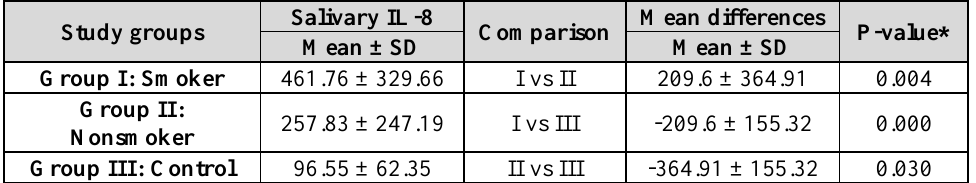
Table 2: Comparison of the three groups with respect to salivary IL-8